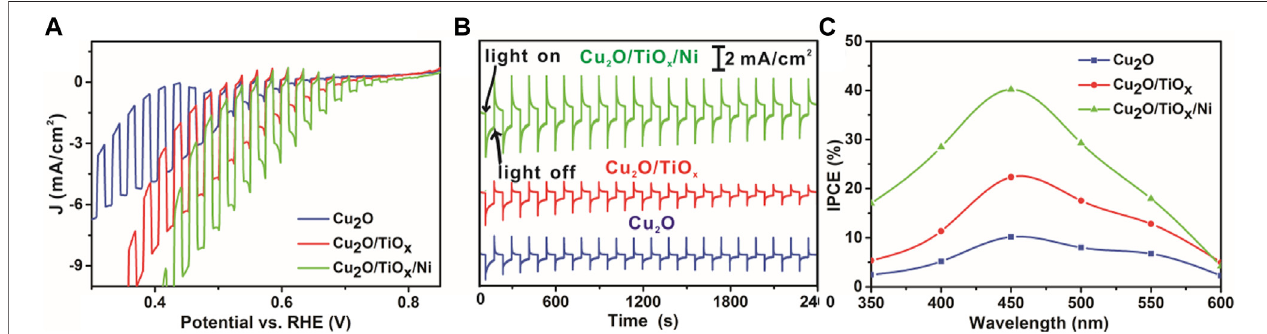
FIGURE 5 | Current-potential (I – V) characteristics curve, stability, and IPCE test (A) I – V curves under chopping simulated AM 1.5G illumination (B) stability measurements with constant bias at 0.6 V vs . RHE and under simulated AM 1.5G illumination (C) IPCE of pristine Cu 2 O NWAs, Cu 2 O/TiO x NWA, and Cu 2 O/TiO x /Ni NWA samples (all tests performed in pH = 6